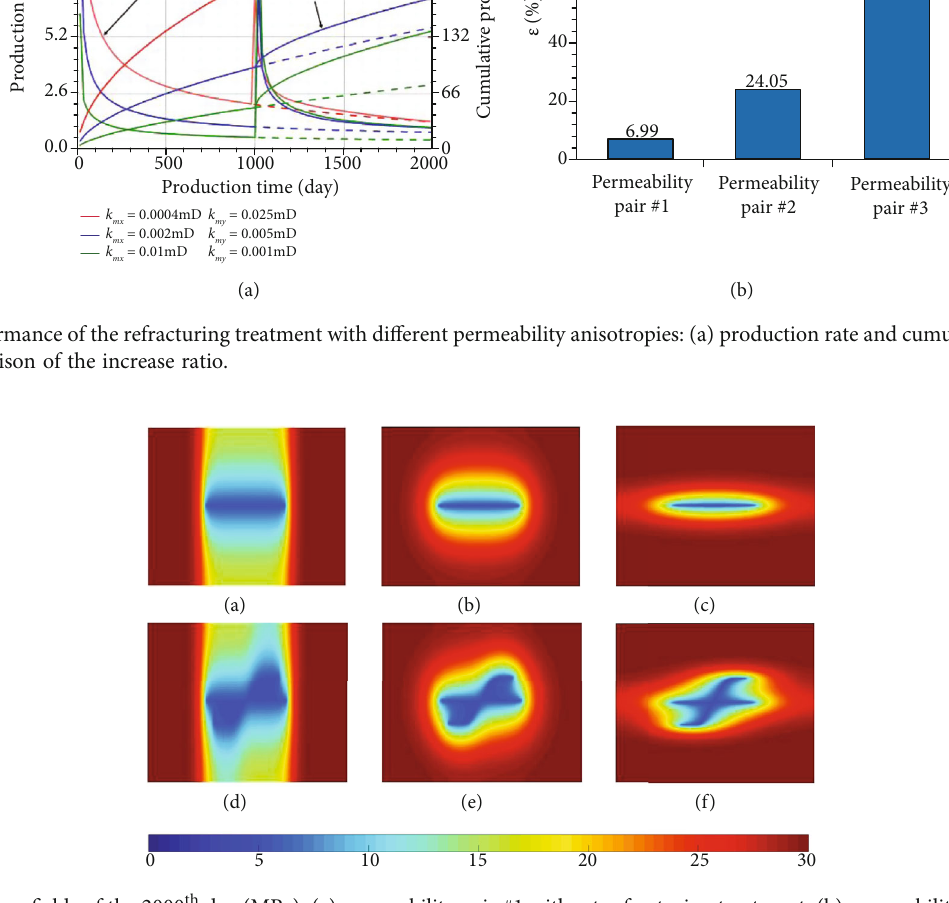
Figure 4: Pressure fi elds of the 2000 th day (MPa): (a) permeability pair #1 without refracturing treatment, (b) permeability pair #2 without refracturing treatment, (c) permeability pair #3 without refracturing treatment, (d) permeability pair #1 with refracturing treatment, (e) permeability pair #2 with refracturing treatment, and (f) permeability pair #3 with refracturing